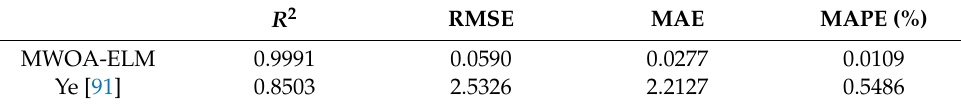
Figure 22. Regression analysis result of the MWOA-ELM and Mathematical model. Table 10. Evaluation indicators for the MWO-ELM and Mathematical model.